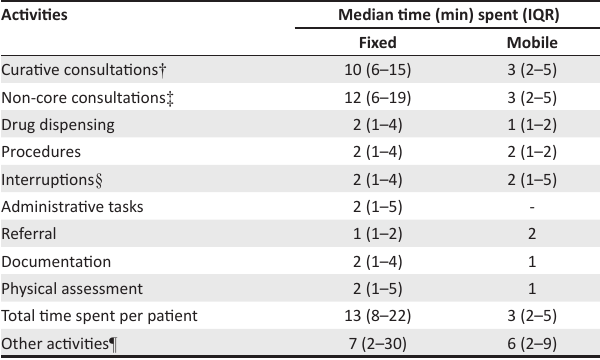
TABLE 3: Median time spent per